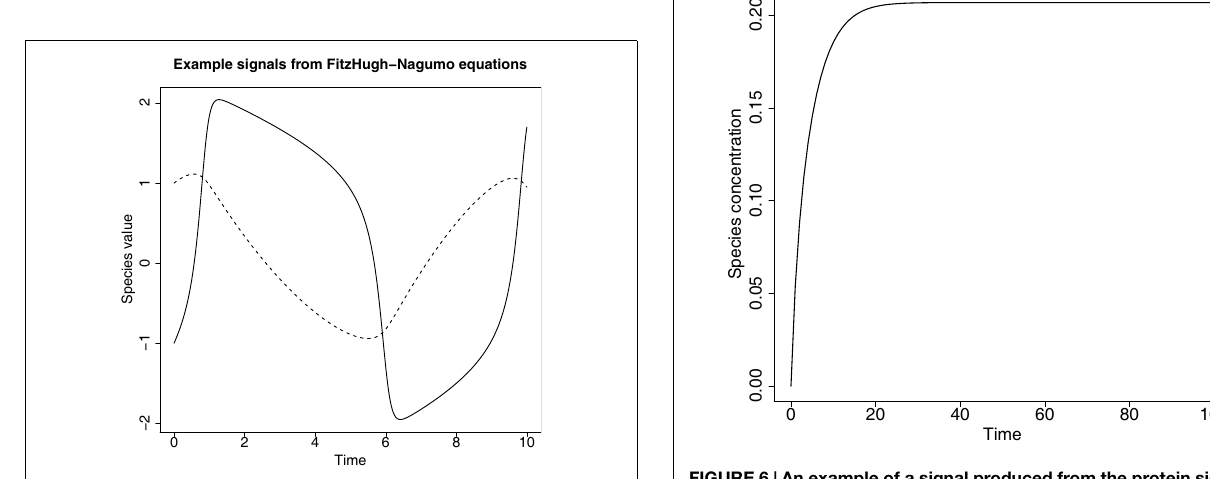
FIGURE 6 | An example of a signal produced from the protein signaling transduction pathway in equation (64) . The signal represents species dS and shows a rapid change in concentration before it plateaus, which is a feature typical of the remaining species’ signals in equations